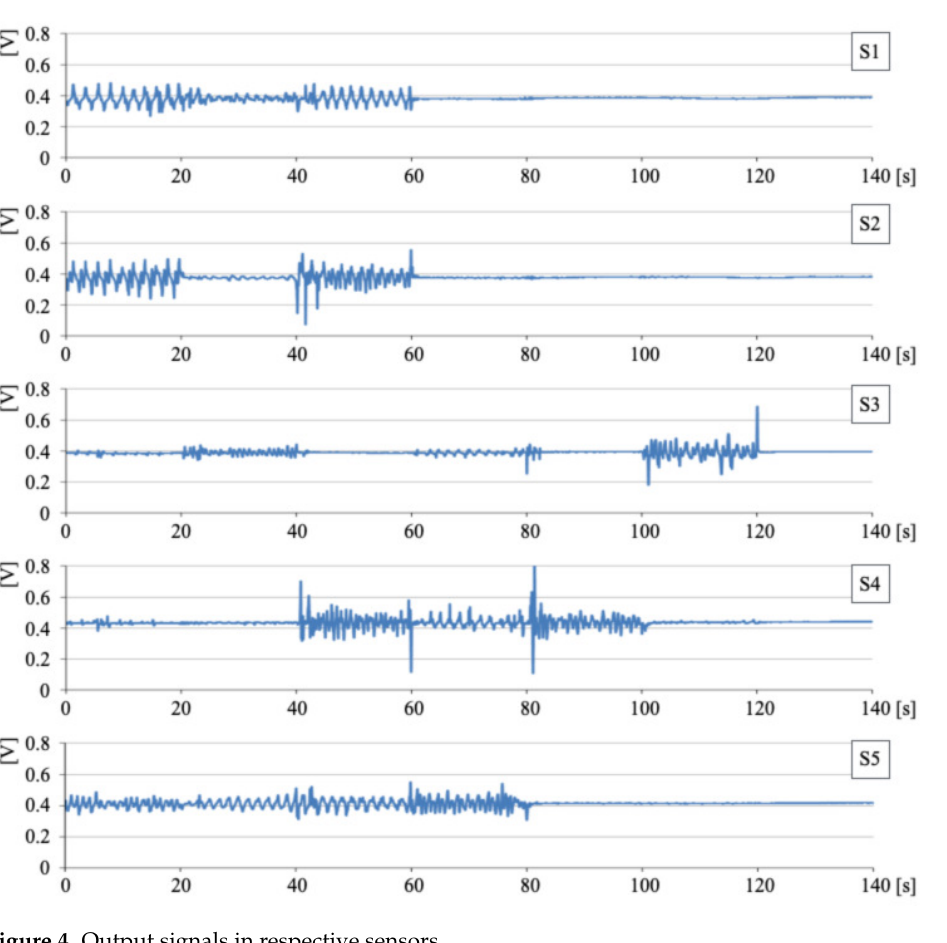
Figure 4. Output signals in respective